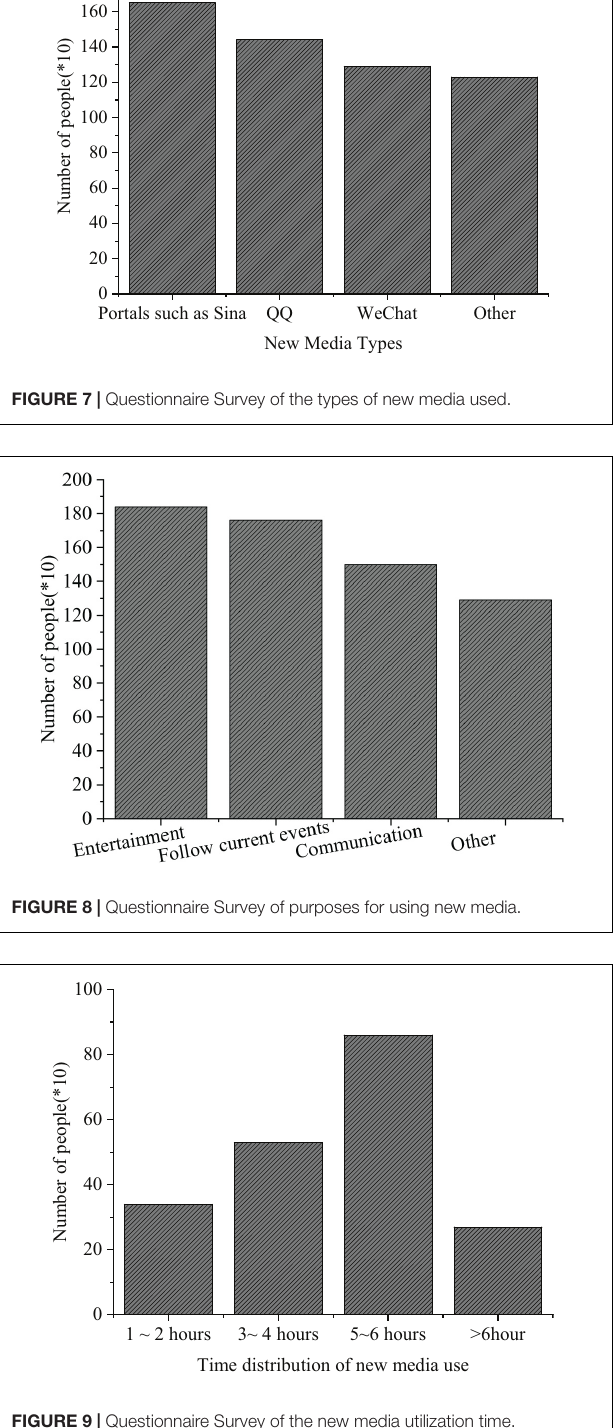
departments are involved in the organization and coordination of entrepreneurial courses, leading to an incomplete innovation and entrepreneurship education